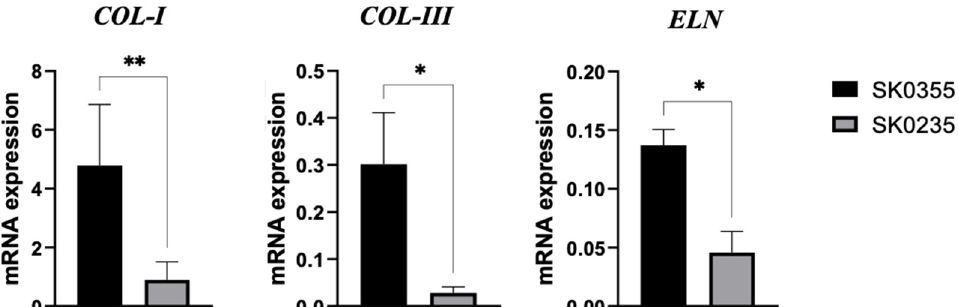
Figure 3. Dermal fibroblast expression of ECM molecules. Human dermal fibroblasts SK0355 from a 30-year-old woman) and SK0235 (from a 54-year-old woman) were cultured and their expression of collagen type I (COL-I), collagen type III (COL-III) and elastin (ELN) were compared. RNA transcript levels were evaluated by qPCR. Data are reported as mean ± SE of three independent experiments. Statistical differences based on unpaired Student’s t-test. * p < 0.05 and ** p < 0.01.